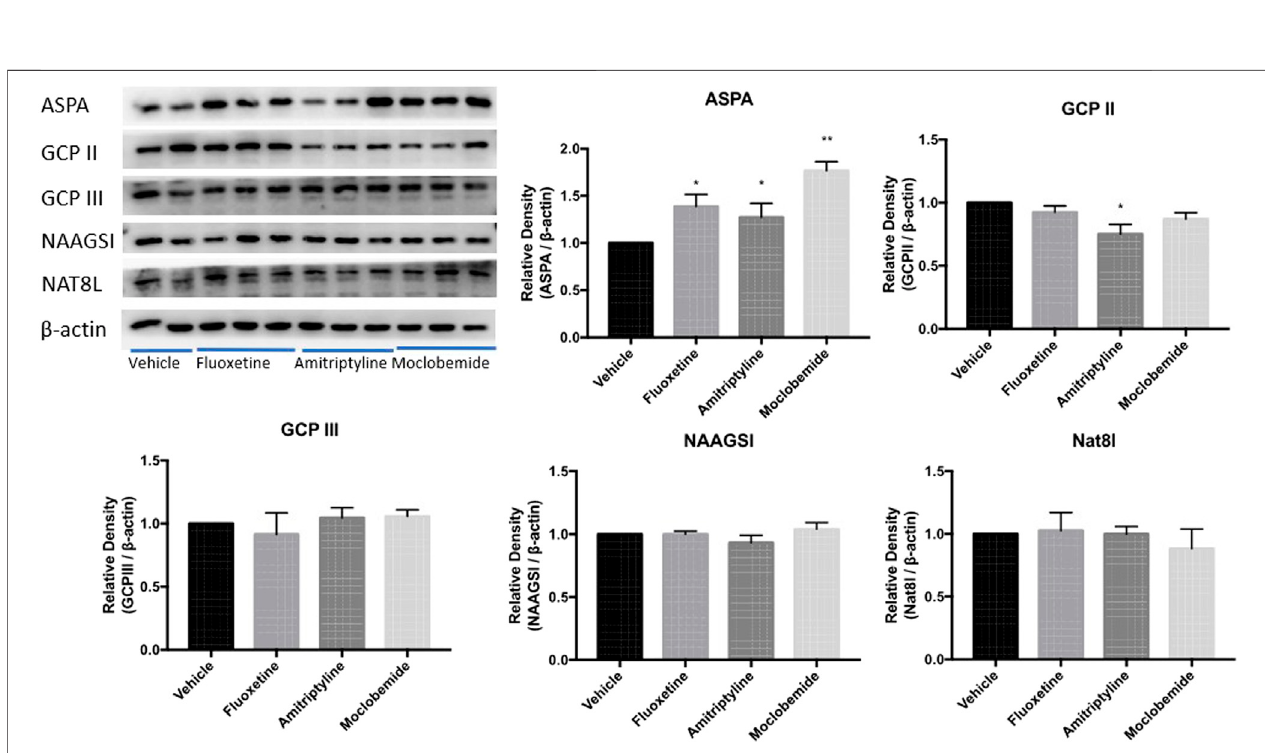
FIGURE 5 | Effects of other three kinds of monoamine-based antidepressants on NAA- related enzyme expression in CeA in rats exposed to 0.5 h of WIRS. Pretreatment with 10 mg/kg fl uoxetine, 10 mg/kg amitriptyline, and 20 mg/kg moclobemide all increased ASPA levels in the condition of WIRS for 0.5 h, which were consistent with duloxetine. Amitriptyline also reduced GCPII level. ASPA/GCP II/GCP III/NAAGSI/Nat8l was normalized to β -actin. Values are expressed as means ± SEM. * p < 0.05, ** p < 0.01, compared with vehicle group. ( n = 4 in fl uoxetine group, n = 5 in moclobemide group, n = 6 in vehicle and amitriptyline group)